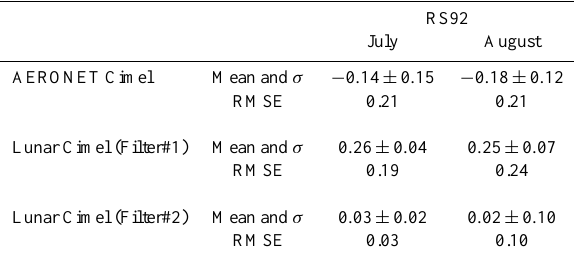
Table 5. Mean, standard deviation σ and RMSE (cm) of the PWV difference (photometer minus RS92 data) obtained from the com- parison study between diurnal CA, nocturnal LC and RS92